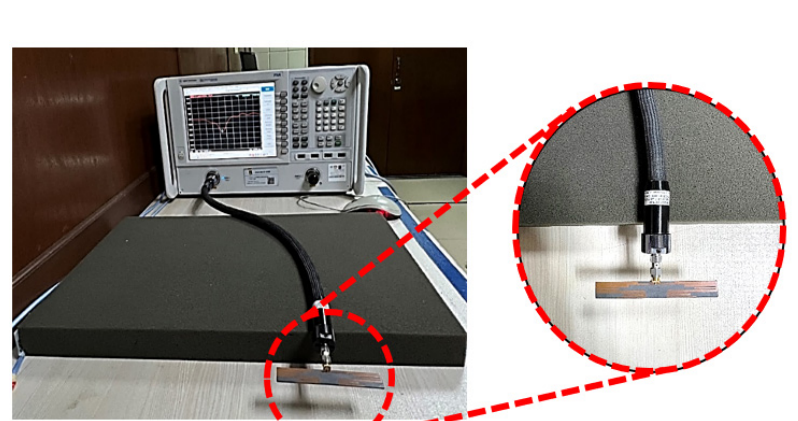
Figure 9. Simulated and measured gain for a monopole array antenna.